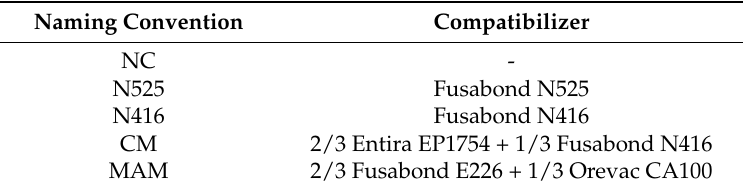
Table 8. Naming of the compatibilizers used. The fractions present the weight ratio.